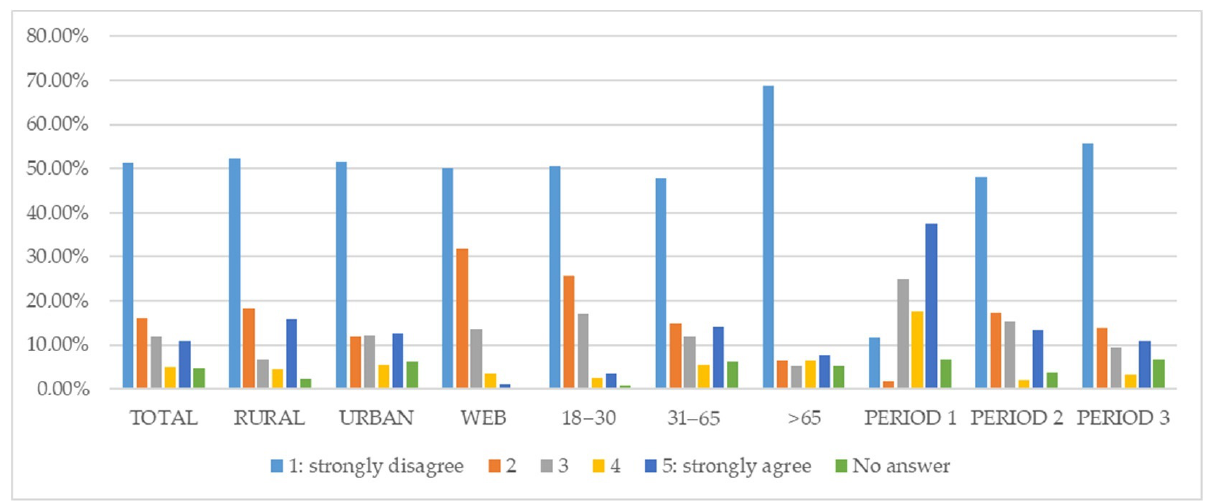
Figure 1. Services that have to be implemented in the future according to the opinion of the interviewed customers.